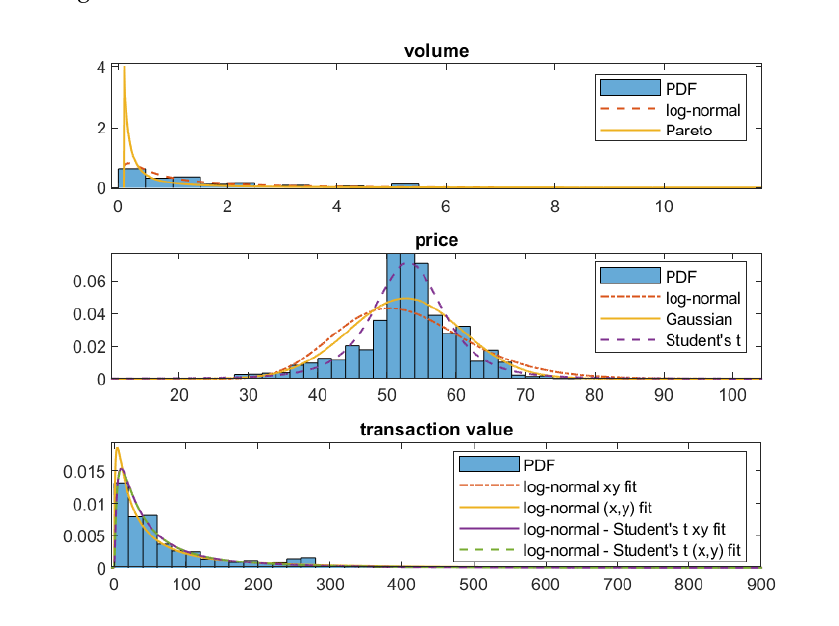
Figure 13. Probability distribution of the volume ( top panel ), price ( middle panel ) and their product, i.e., the transaction value ( bottom panel ) from the continuous intraday energy market data